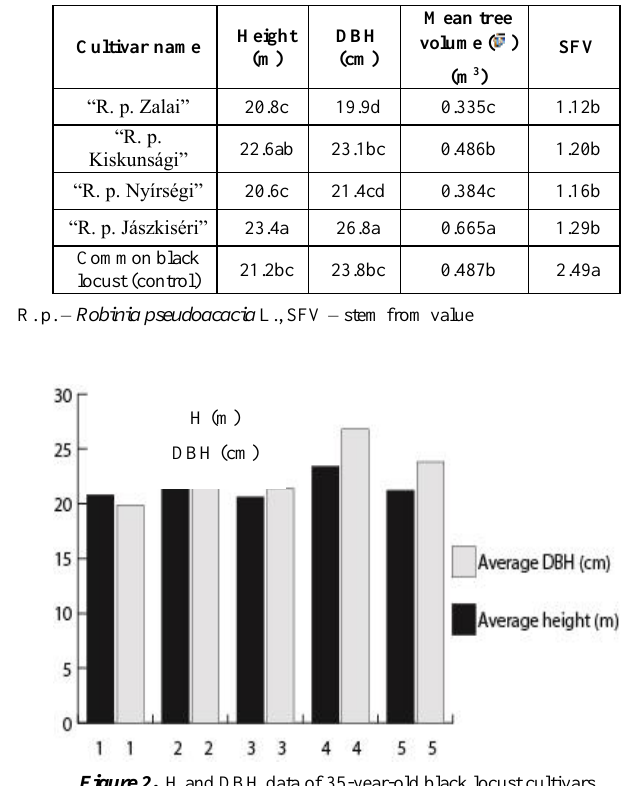
Table 2. The least significant difference test (LSD 0.05 ) of the most important parameters of stand structure at the age of 35 years